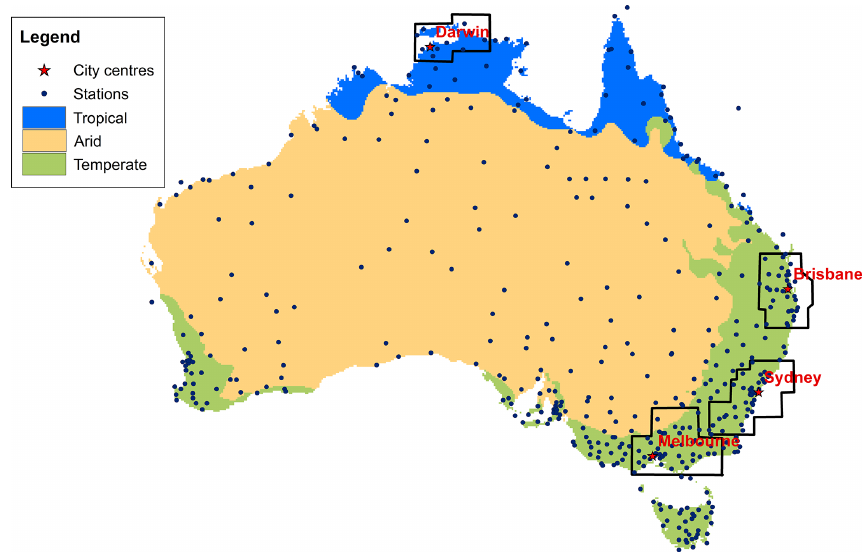
Figure 1. Study area with locations of pluviometer gauges (points) and the radar data (boxes surrounding city centres). The locations of radar datasets are the Darwin, Brisbane, Sydney, and Melbourne regions. The climatic classification is adapted from Peel et al.